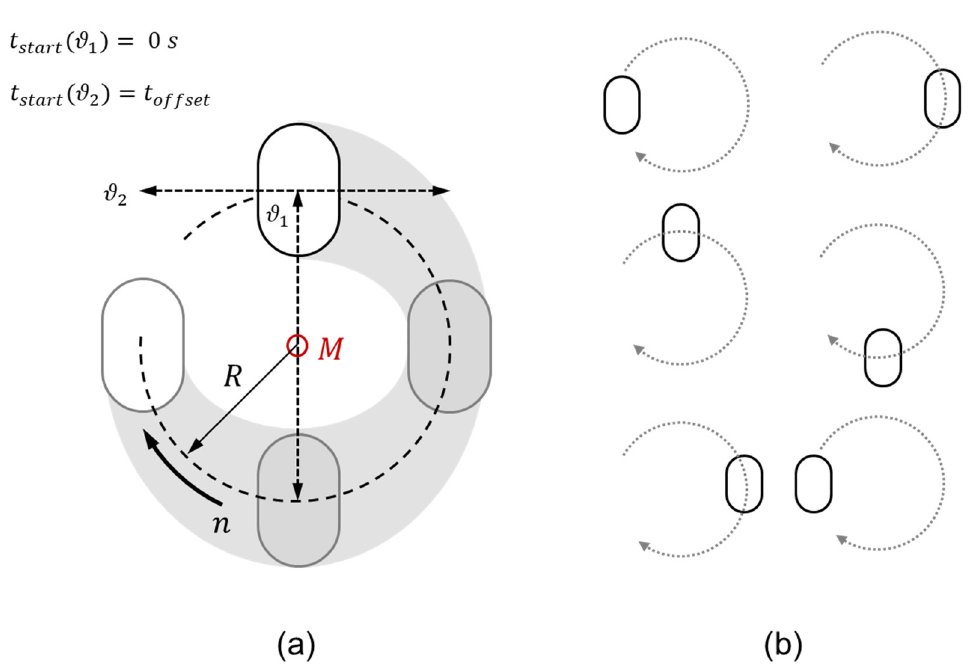
Figure 1. Circular movement of one milling chamber: ( a ) implementation in the DEM simulation by superimposition of linear oscillations, θ 1 and θ 2 , R = 17 mm; ( b ) chamber positions.